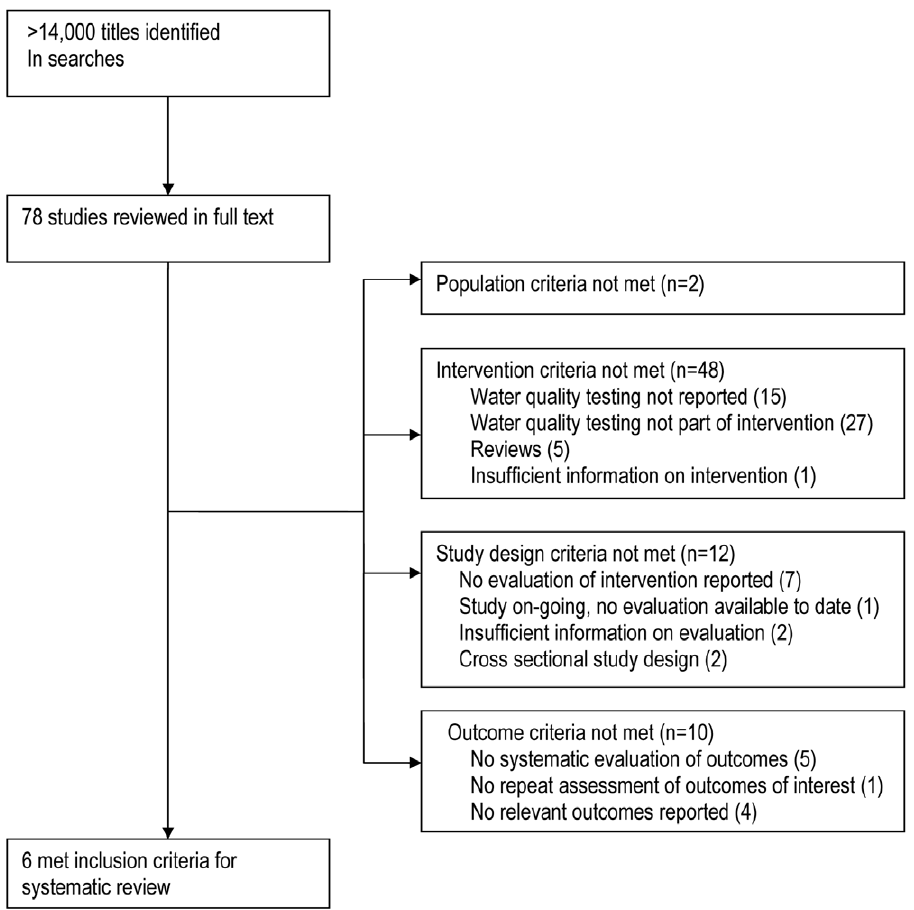
Figure 1. Flow chart of included/excluded studies.